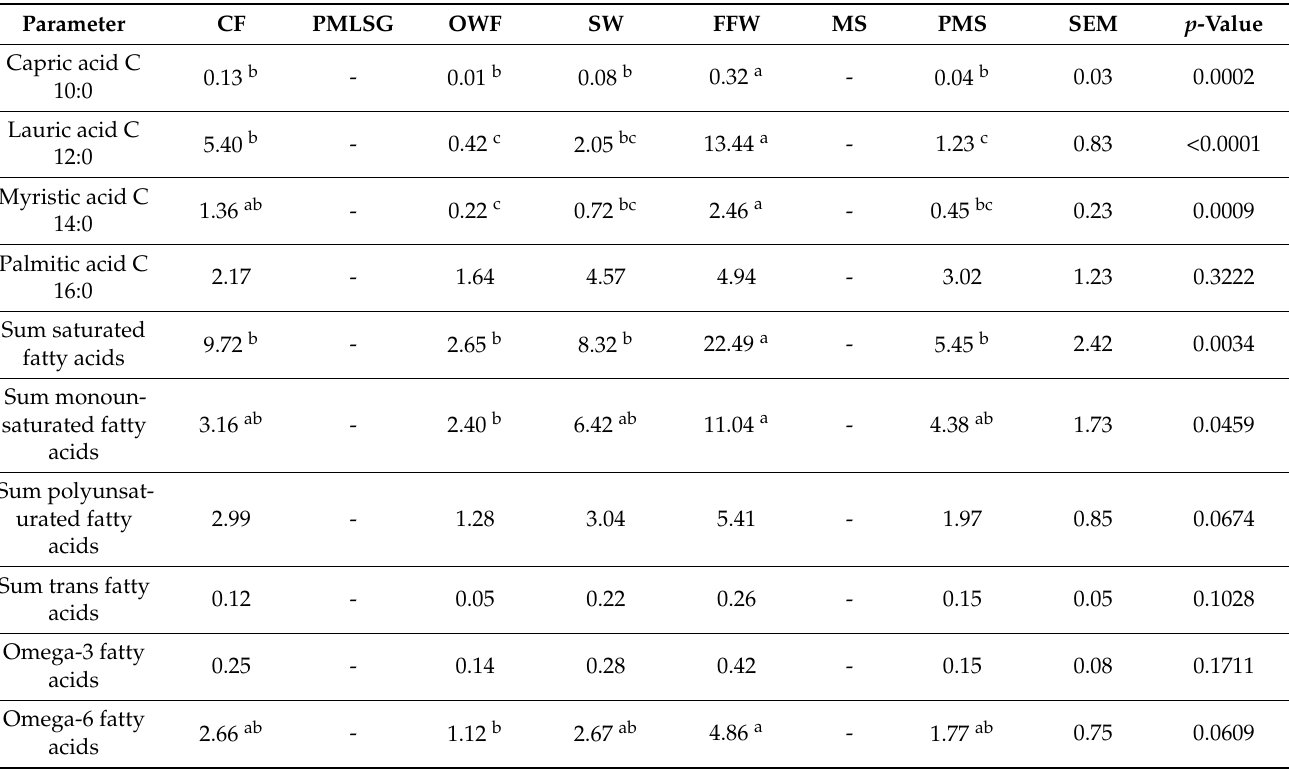
Table 3. Fatty acid profile of the larvae reared on different substrates 1 (fatty acids expressed in % of dry